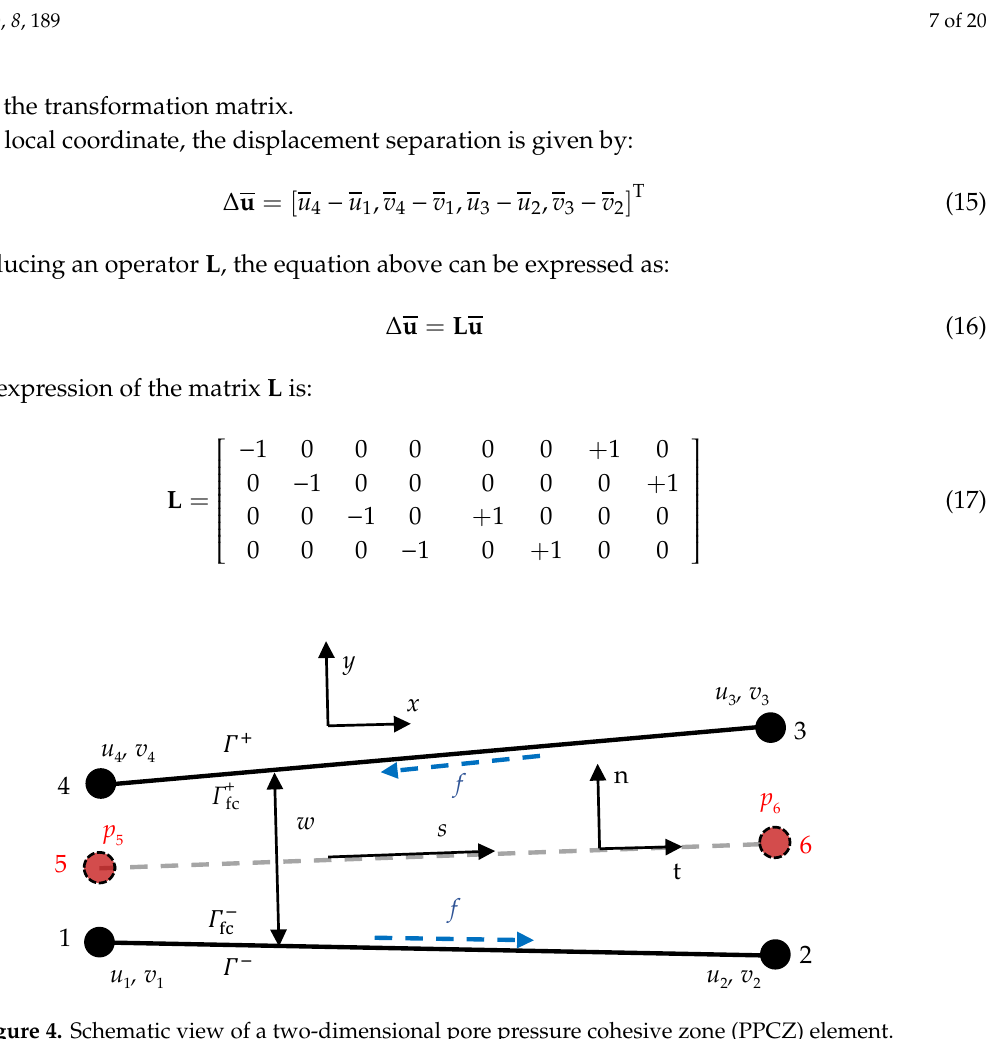
Figure 4. Schematic view of a two-dimensional pore pressure cohesive zone (PPCZ) element.